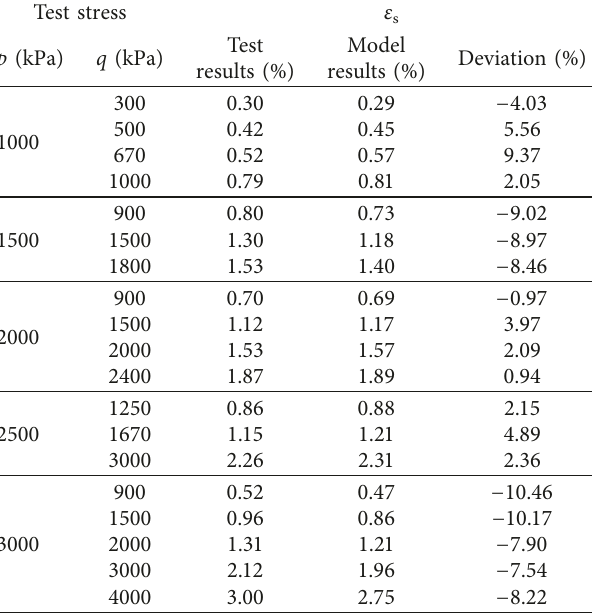
Figure 9: ε s versus q curve (comparison of experimental and model results). Table 7: Test stress conditions and results (compared with test results and model results for ε s ).